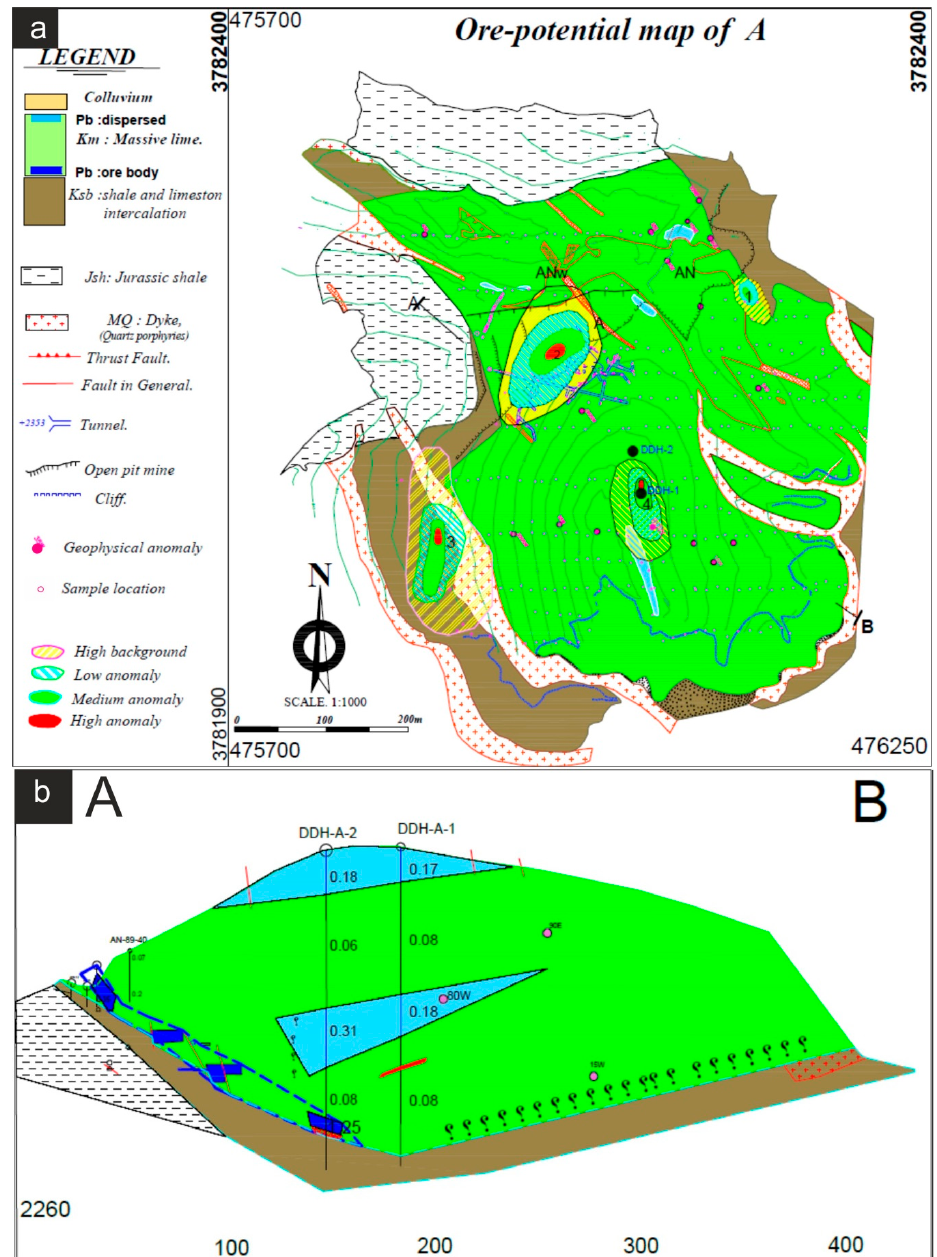
Figure 9. ( a ) Ore potential map of Block A of the Ravanj deposit; and ( b ) cross section of the Block A along the orebody which intersected first and second anomalies.